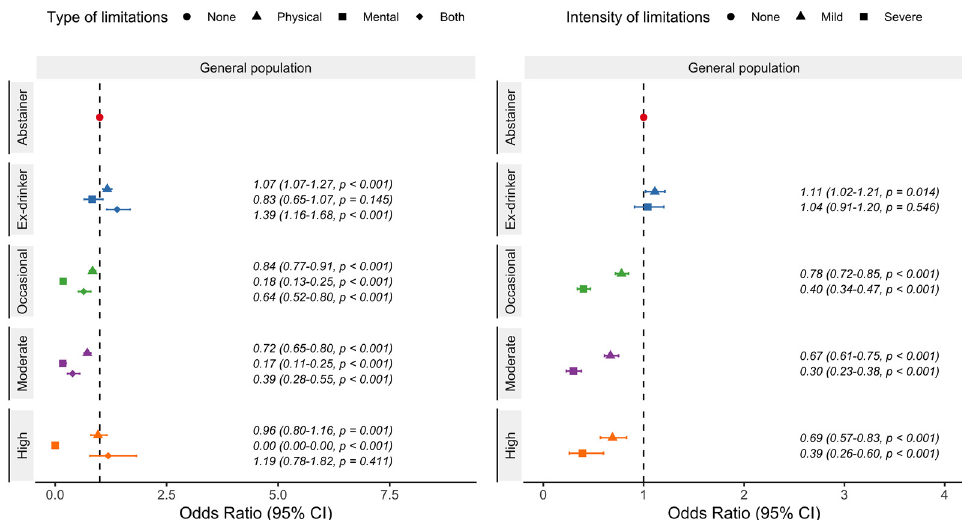
Figure 3. Odds ratio and 95% confidence intervals of reporting daily physical, mental, or both limitations and daily mild or severe limitations in the Spanish adult population ( ≥ 18 years) according to beer consumption. Drinkers were classified as occasional (a maximum of 3 days per month), moderate (women: up to 12 g of alcohol per day; men: up to 24 g of alcohol per day), or high (women: more than 12 g of alcohol per day; men: more than 24 g of alcohol per day). Analyses adjusted for age, gender, social class, educational level, year of the survey, place of residence, physical activity, diet, tobacco, and body mass index. National Health Survey of Spain 2012, 2017.